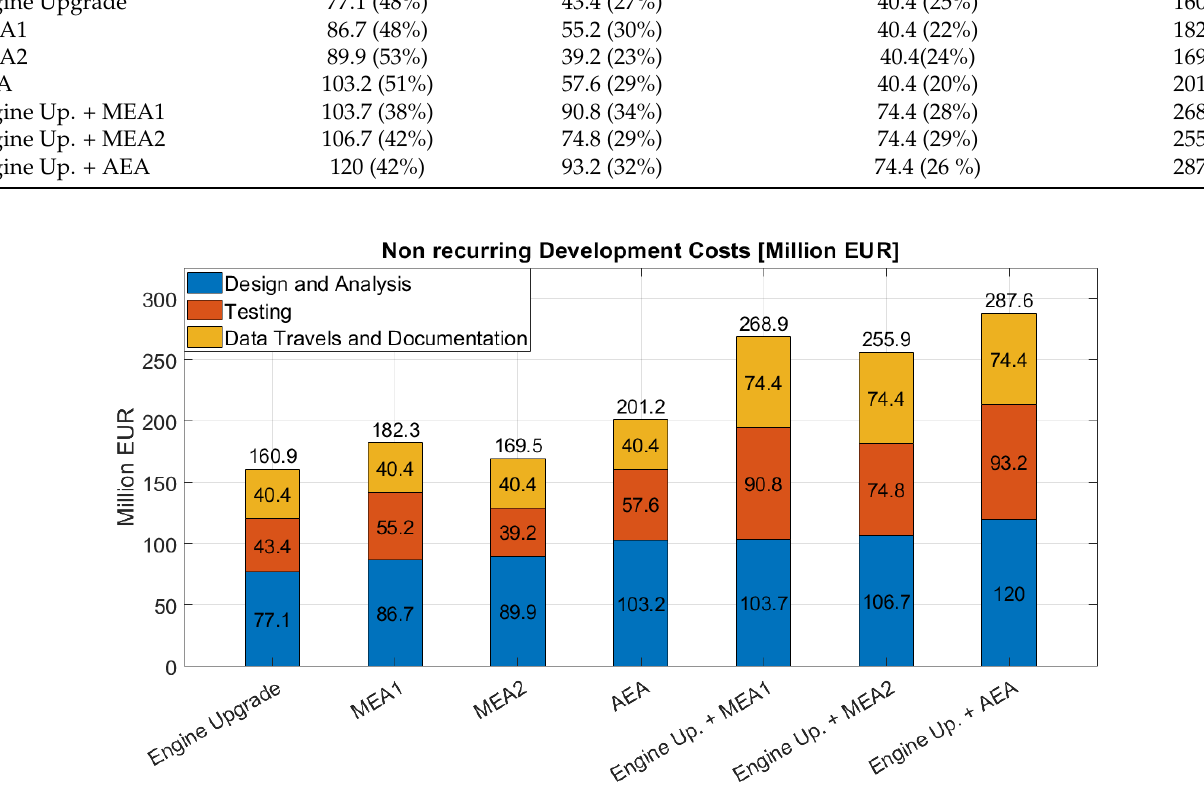
Figure 4. The trends of the main development costs required for seven different retrofits.